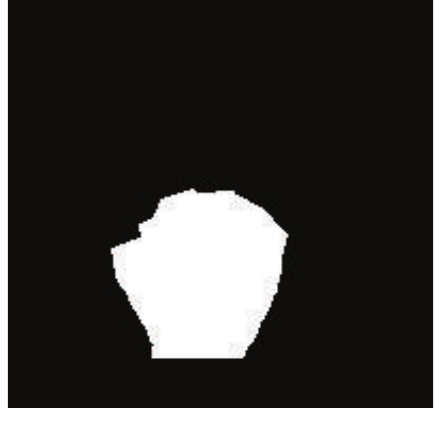
Figure 5: The distance transform of the hand image in Figure 3.